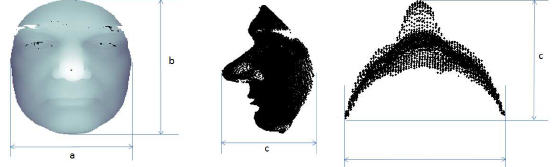
Fig. 8. a,b and c are the width, height and depth of the 3D face